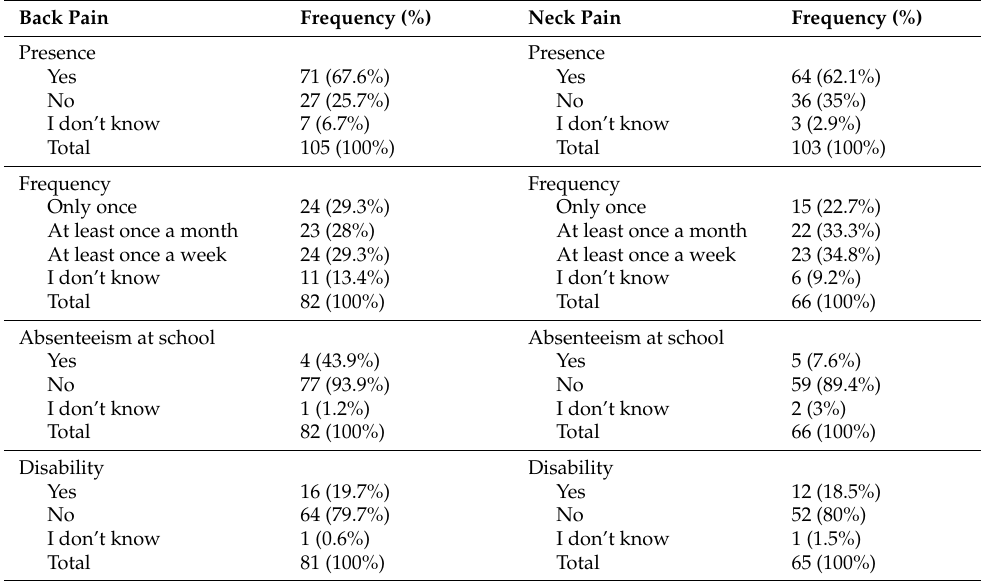
Figure 3. Distribution of school children by gender and age (Porto Alegre, Brazil, 2020). Table 1. Sample characteristics related to back pain and neck